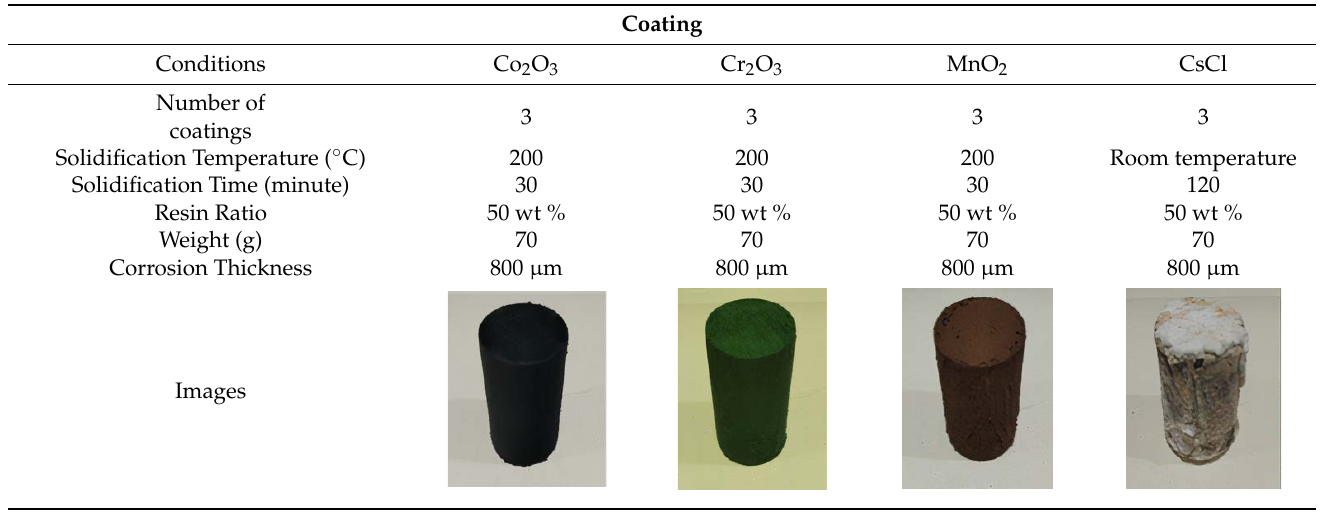
Table 6. S41C specimen fabrication methods.